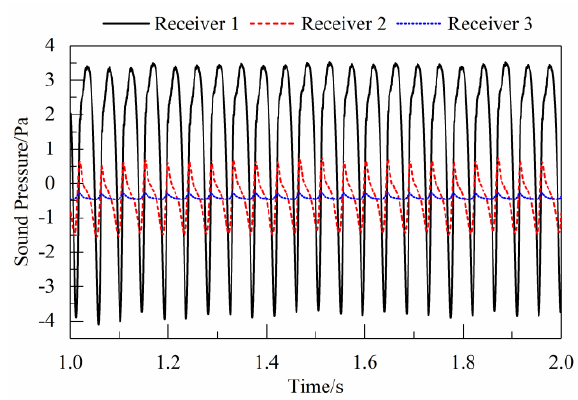
Figure 11. Sound pressure curve with variation of time at three different observing points.